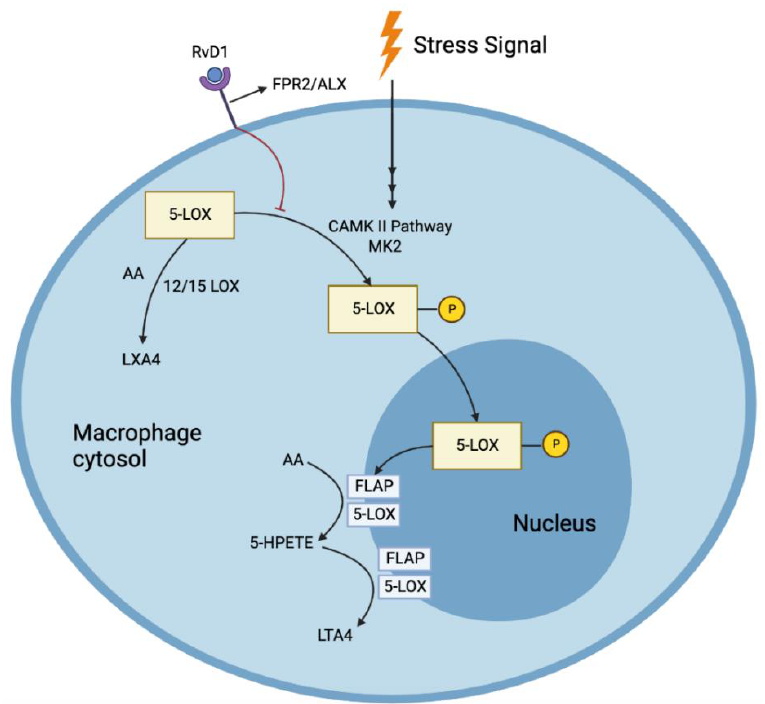
Figure 3. RvD1 prevents the nuclear location of 5-LOX, increasing the production of pro-resolving LXA4 and reducing the production of pro-inflammatory LTA4 in response to stress signals. Akagi et al. demonstrated that pretreatment of ASMCsin vitro with DHA-derived SPMs, RvD2, and maresin-1(MaR1), impaired their migration towards PDGF in a dose- dependent manner by 74% and 80%, respectively at a 100 nM concentration [38]. They also showed that GPCR could have mediated this response since the reduction in migra- tion was attenuated in the presence of PTX, which inhibits GPCR proteins [20,36,38]. Of the many immunologically act ive cytokines, TNFα induces the NFκB pathway by nuclear translocation of p65 (Figure 4). This pathway results in the transcription of many pro- inflammatory cytokines such as TNFα, Interleukin (IL) -1, IL-6, and IL-8. An in vitro study showed that RvD2 or MaR1 treatment of mouse ASMCs reduced p65 nuclear transloca- tion by 24% and 28%, respectively, at a concentration of 500 nM. At the same concentra- tion, such treatment also has reduced TNF- α induced superoxide production by 46% and 53%, respectively [38]. Furthermore, RvD2 reduced the cultured VSMCs production of VCAM-1 and ICAM-1 induced by TNF- α [20]. Such effects of these two SPMs demonstrate their anti-inflammatory and pro-resolving characteristics in their local environment. This pro-resolving action reduced the neo-intimal hyperplasia (neointima: media area ratio), which has been proven to be a result of chronic inflammation, by 67% and 71% by RvD2 and MaR1, respectively. The same study also showed a decrease in migration of neutro- phils and monocytes to the area of injury, achieved by the suppression of MCP-1 expres- sion by activated VSMCs and an increase in the M2 phenotype of macrophages which promoted resolution of the ongoing inflammation [38].